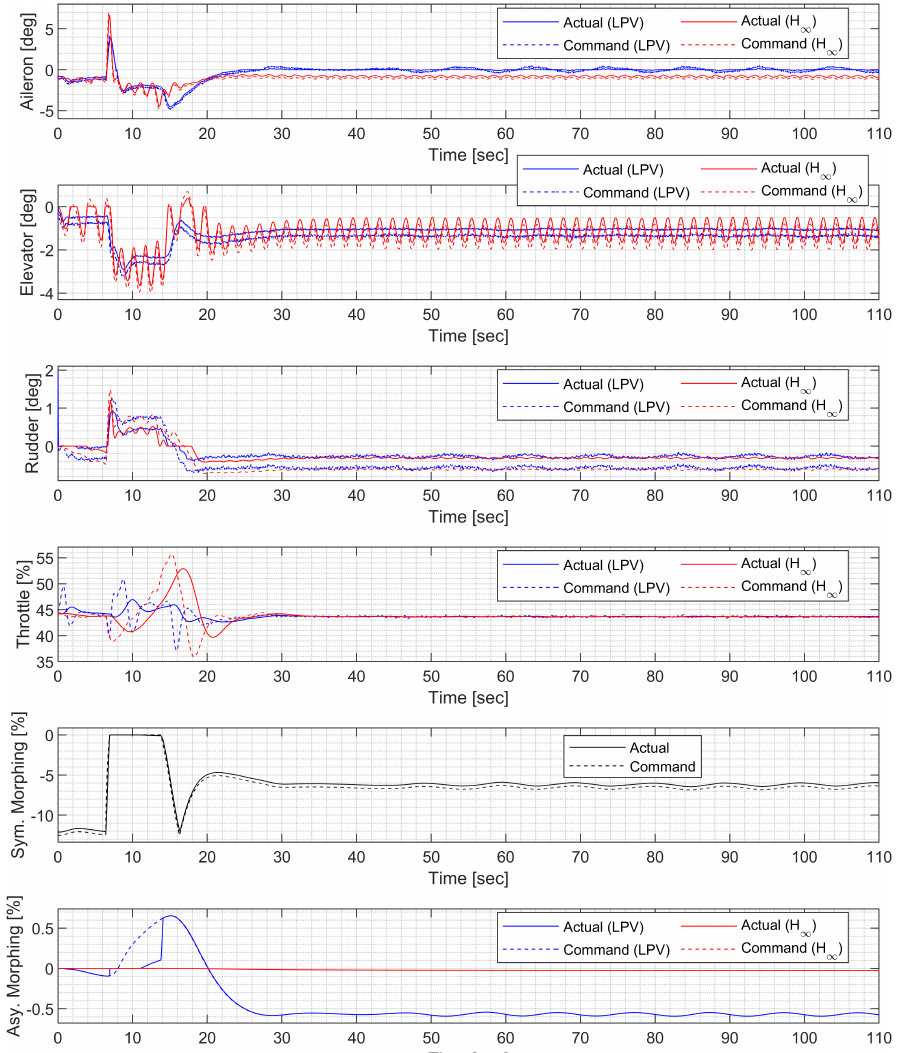
Figure 25. Input history of the circular trajectory-following